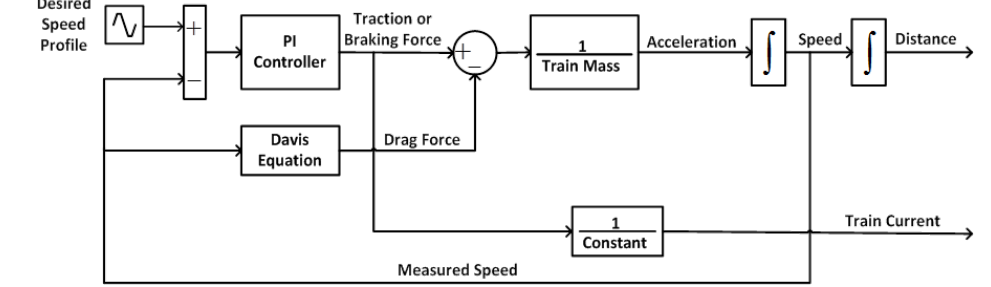
Figure 7. Dynamics of a single train.